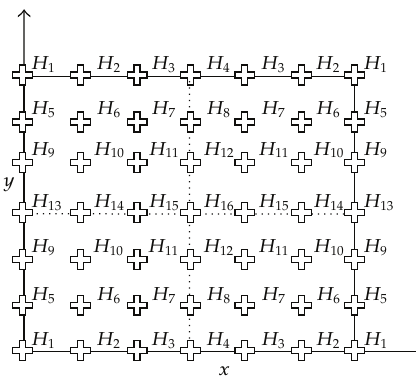
Figure 3: Fin height distribution control points.